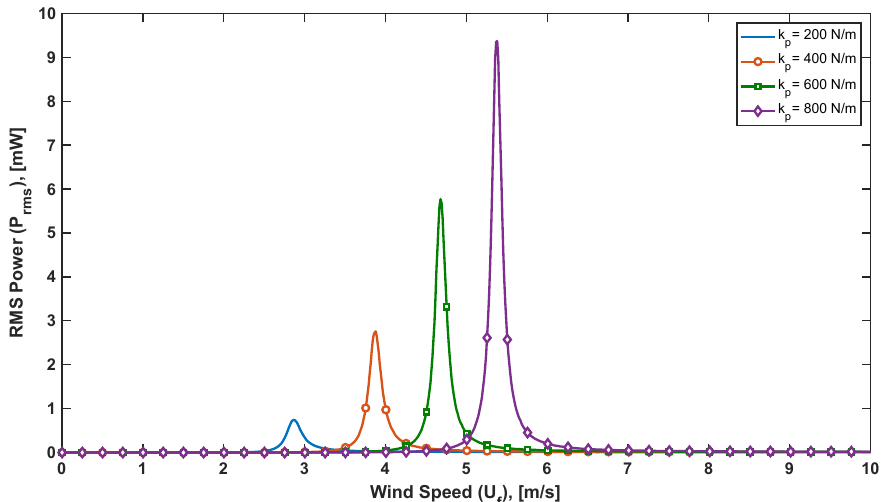
Figure 10. The effect of spring stiffness ( 𝑘 (cid:3043) ) on harvester output power at different wind speeds.